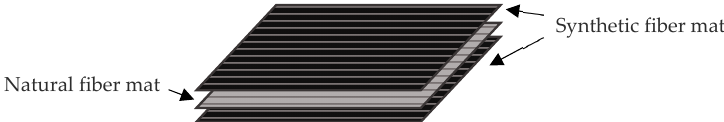
Figure 1. Schematic representation of natural fiber mats sandwiched between synthetic fiber mats.